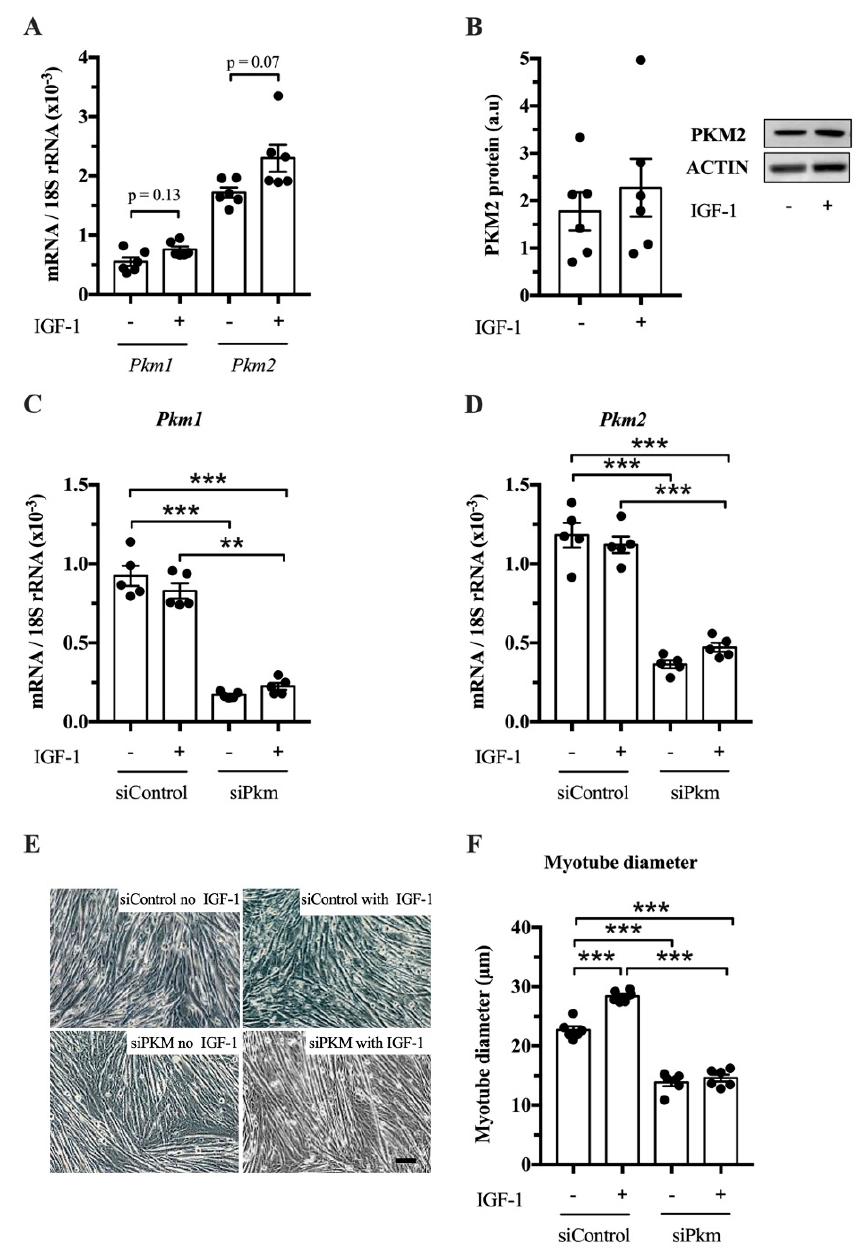
Figure 3. E ff ect of joint knock down of Pkm1 and of Pkm2 on C2C12 myotube size. ( A ) Pkm1 and Pkm2 mRNA in C2C12 myotubes following 24 h IGF-1 treatment. ( B ) PKM2 protein abundance in IGF-1 treated C2C12 myotubes. ( C , D ) Pkm1 and Pkm2 mRNA expression following siRNA interference of Pkm ( n = 5). ( E , F ) C2C12 myotube diameter ( n = 6). Black circles indiciate individual data points. Scale bar is 100 µ m. * Significantly di ff erent between indicated conditions, unpaired t -test, Mann–Whitney U test or two-way ANOVA with Bonferroni post hoc test ( p < 0.05); ** ( p < 0.01); *** ( p <